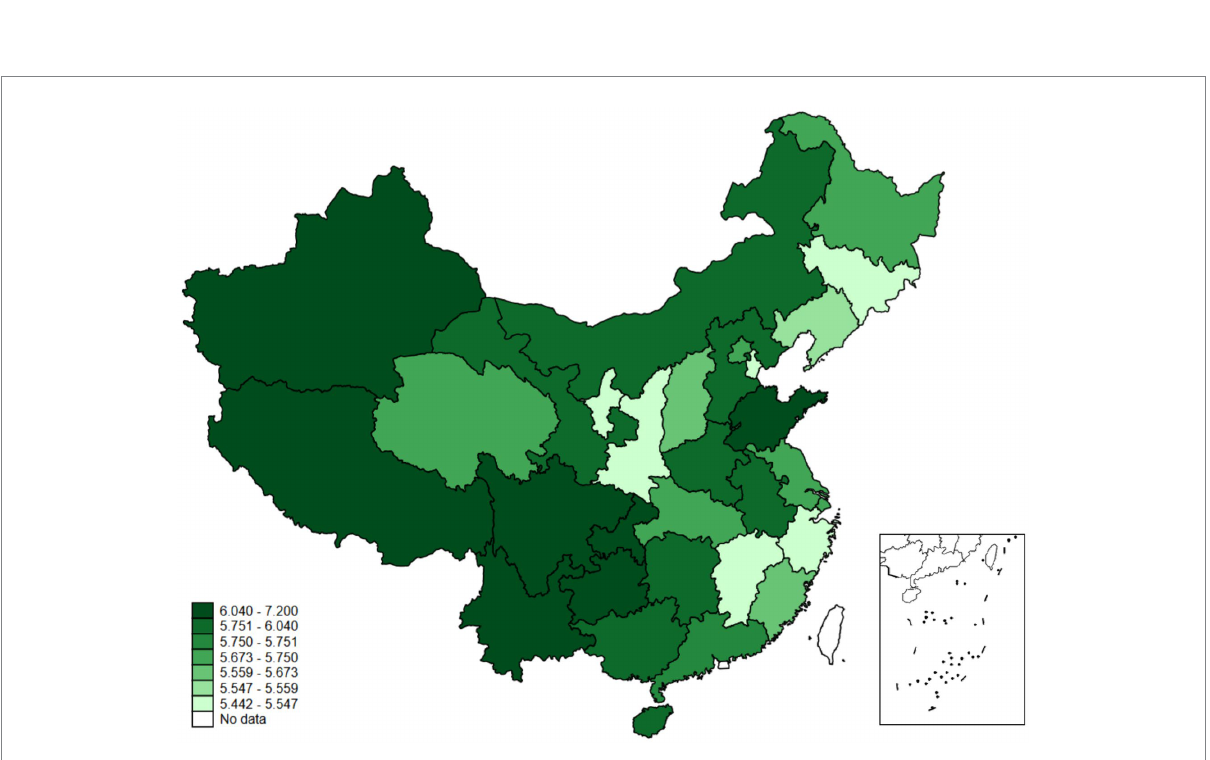
FIGURE 3 Distribution of residents’ trust in the Chinese